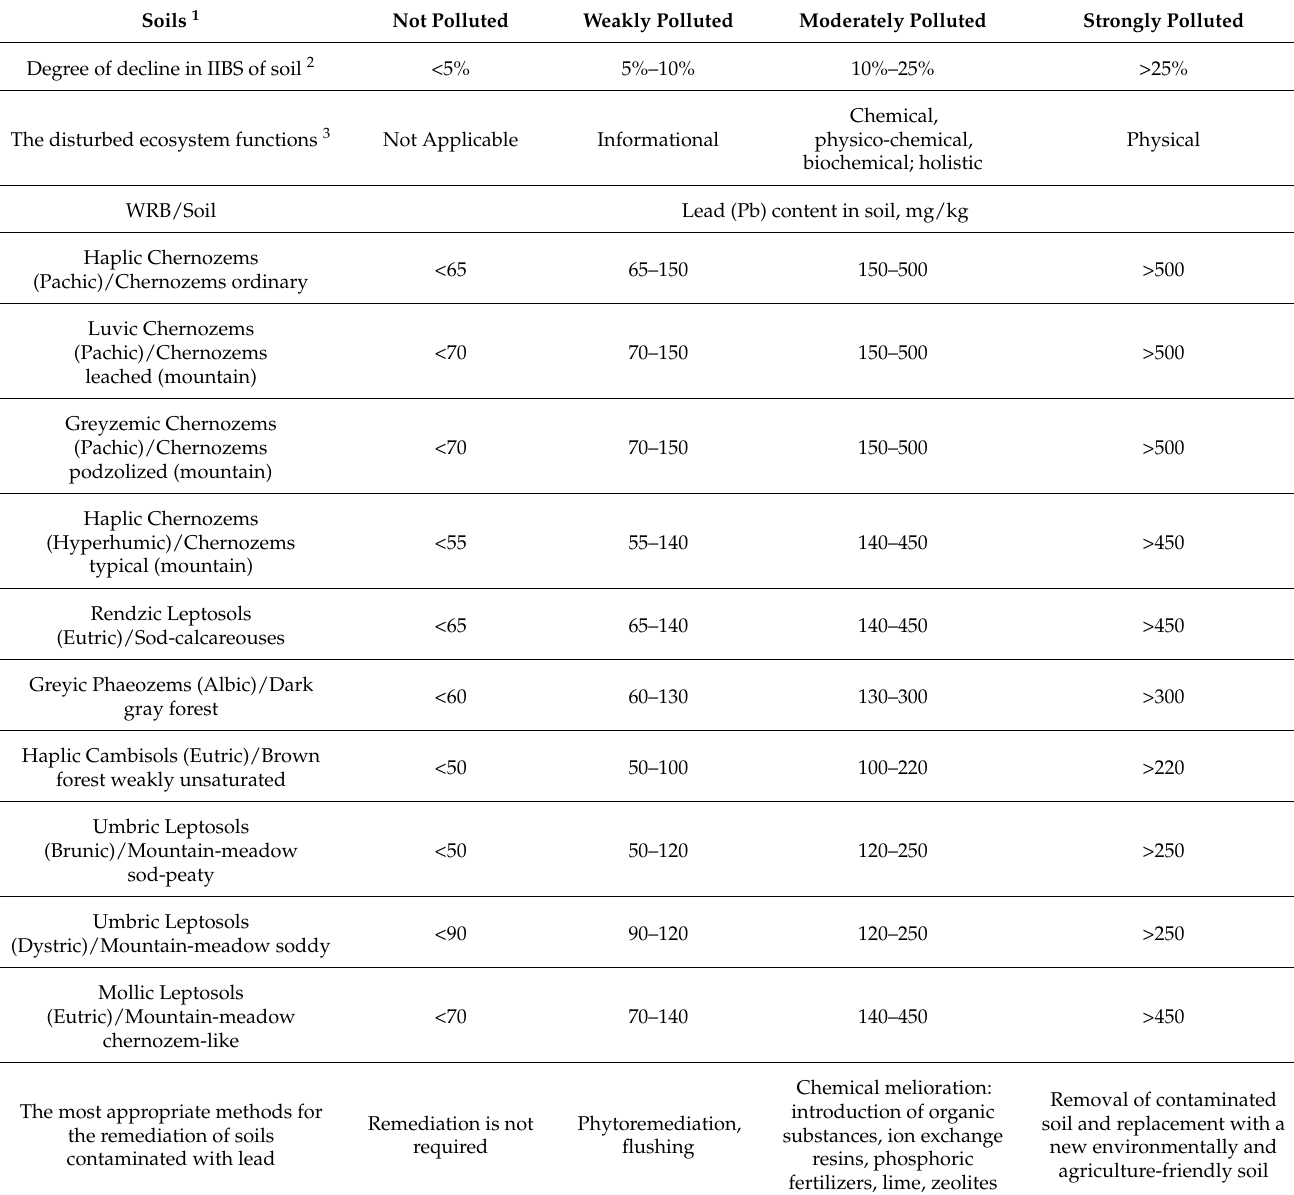
Table 4. Regional standards for the maximum permissible concentration (rMPC) of Pb in forest, forest-steppe, steppe, and mountain-meadow soils according to the degree of violation of ecosystem functions and recommended methods for soil